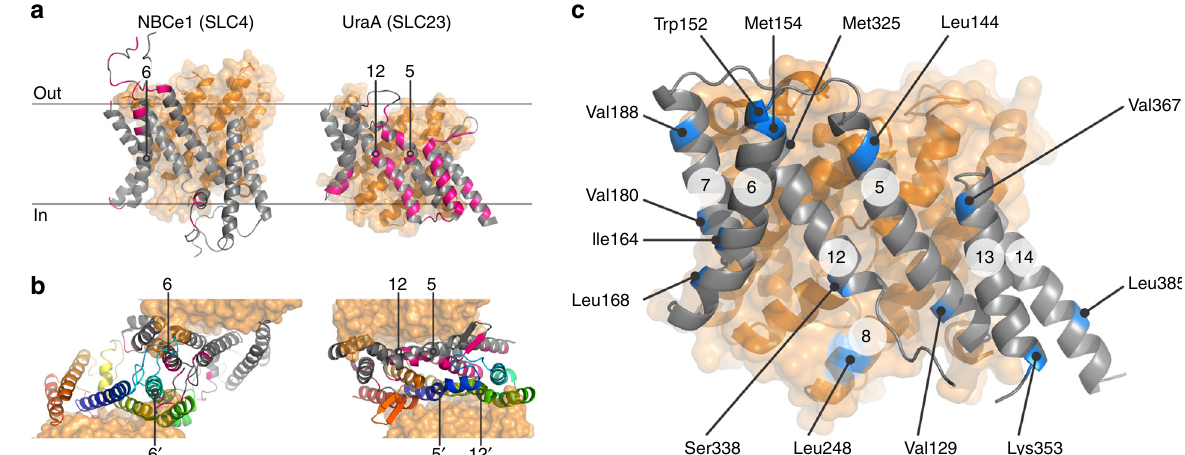
Fig. 1 Dimer interfaces in 7TMIR proteins. a Side view of the membrane domains of NBCe1 (PDB: 6CAA) and UraA (PDB: 5XLS). Core and gate domain are colored orange and gray, respectively, with residues within 4 Å of the opposing protomer in pink. b Top views of the dimeric arrangements of NBCe1 and UraA. For each dimer, the gate domain of one of the protomers follows a rainbow coloring scheme (blue-to-red for N-to-C direction). TMs central in the respective dimers are numbered. c Side view of the membrane domain of SLC26Dg (PDB: 5DA0). Residues mutated to cysteine for site-directed spin labeling are colored blue. The circled numbers indicate the respective